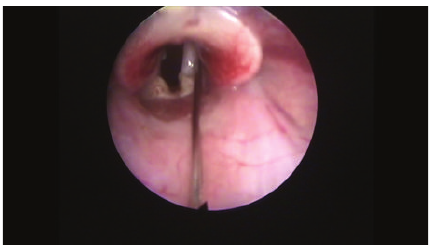
Figure 6: Injection of ADSC.